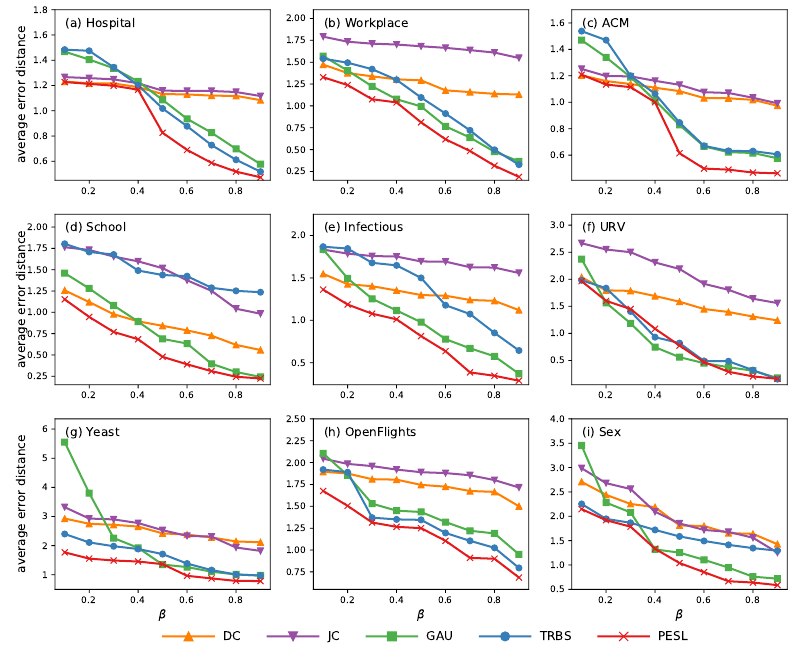
Figure 7. The performance of epidemic source localization accuracy under various infection probability with five algorithms in empirical networks. The number of observers changes due to the scale of network. In ( a – e ), K = 10; in ( f – h ), K = 25; in ( i ), K = 50. The recovery probability used in the simulation is γ = 0.1 and the reporting probability of nodes is δ = 0.3.